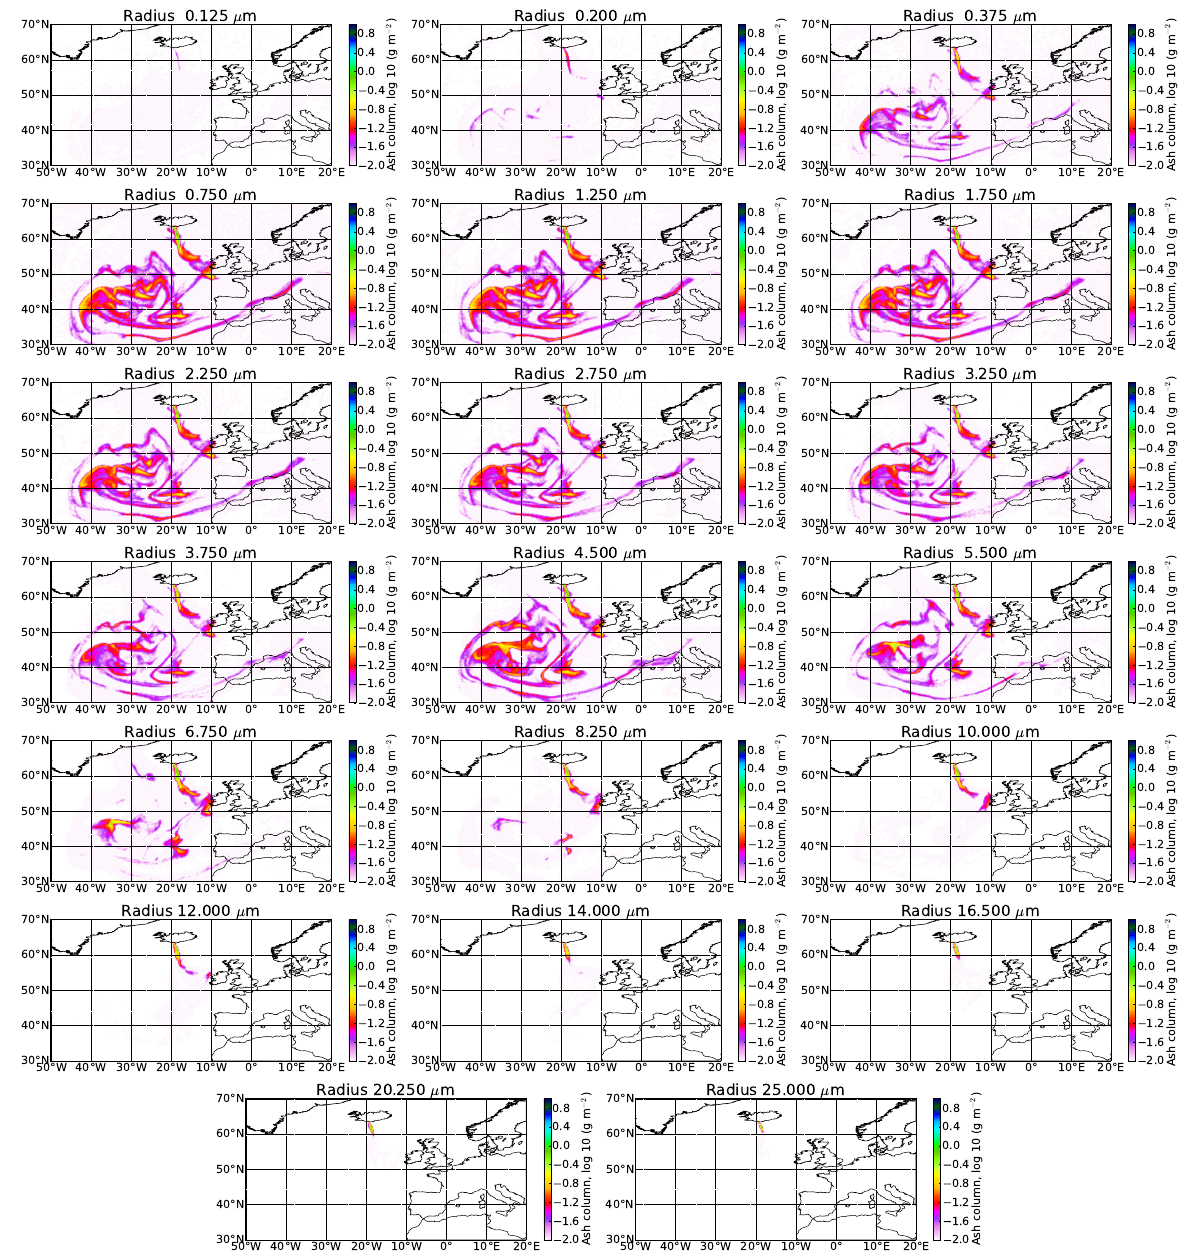
Fig. 1. The total column density of the ash for various particle radii as simulated by the FLEXPART Langrangian particle dispersion model for 11 May 2010 at